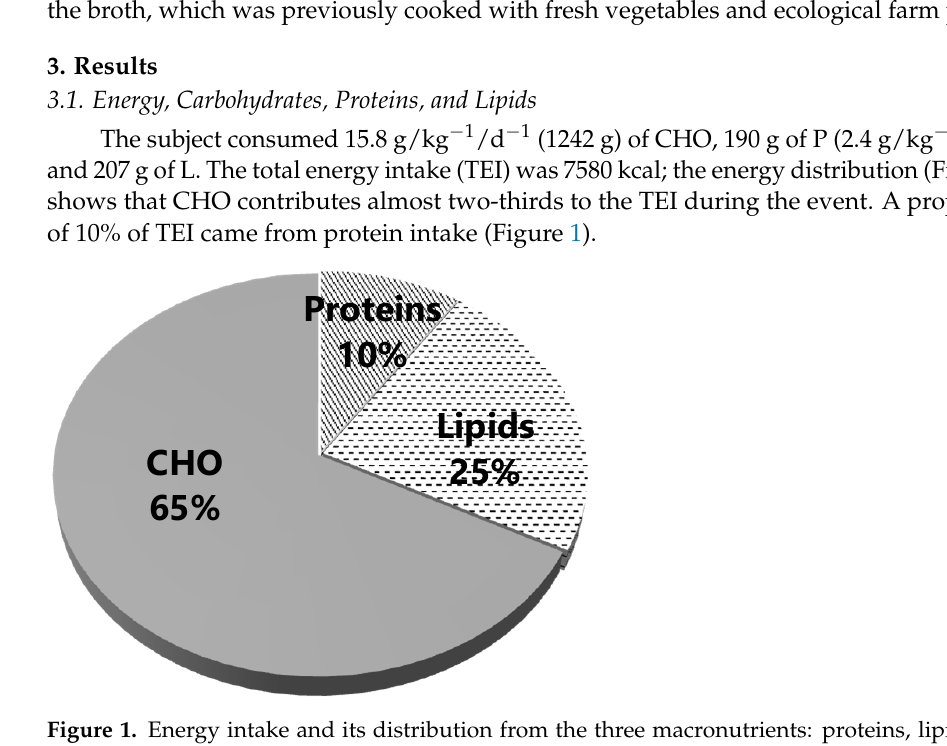
Figure 1. Energy intake and its distribution from the three macronutrients: proteins, lipids, and carbohydrates (CHO).